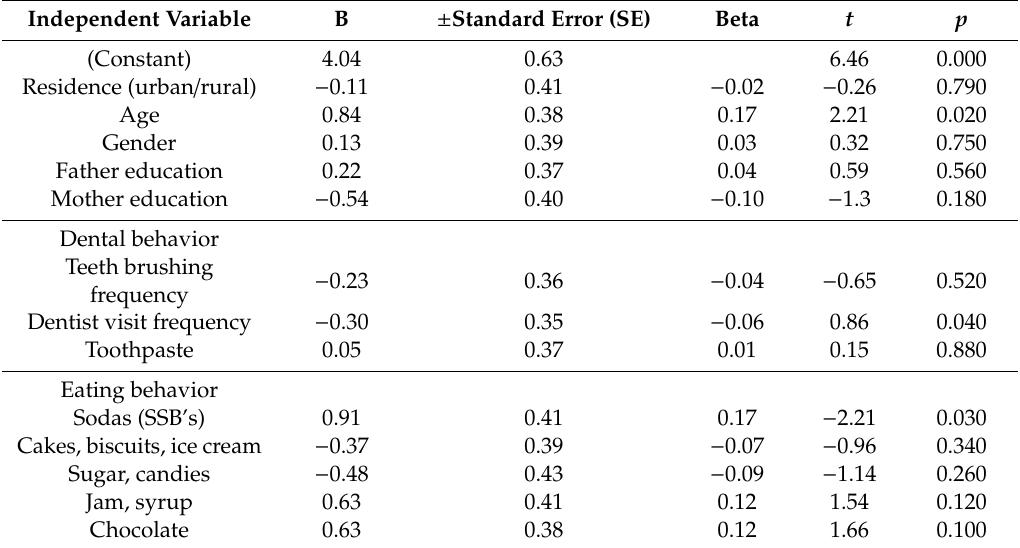
Table 5. Lifestyle factors predicting the DMFT index according to linear